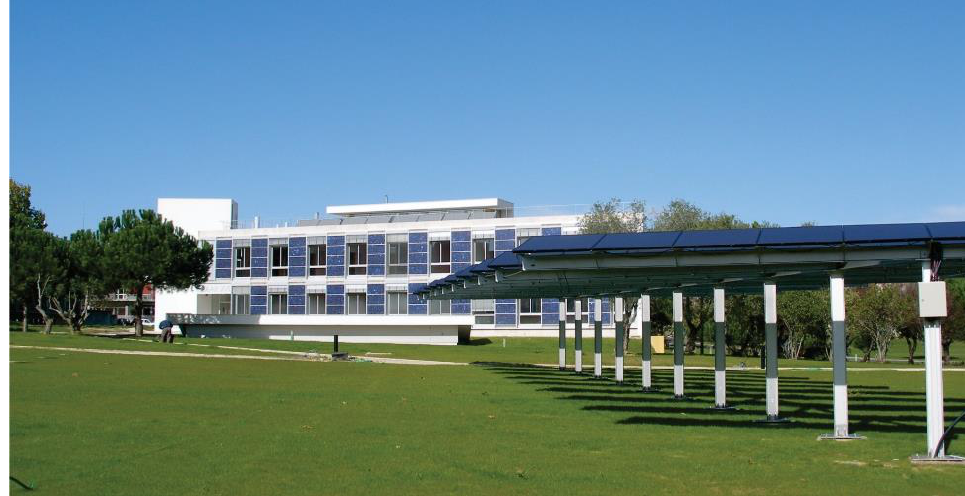
Figure 1. Solar XXI building.